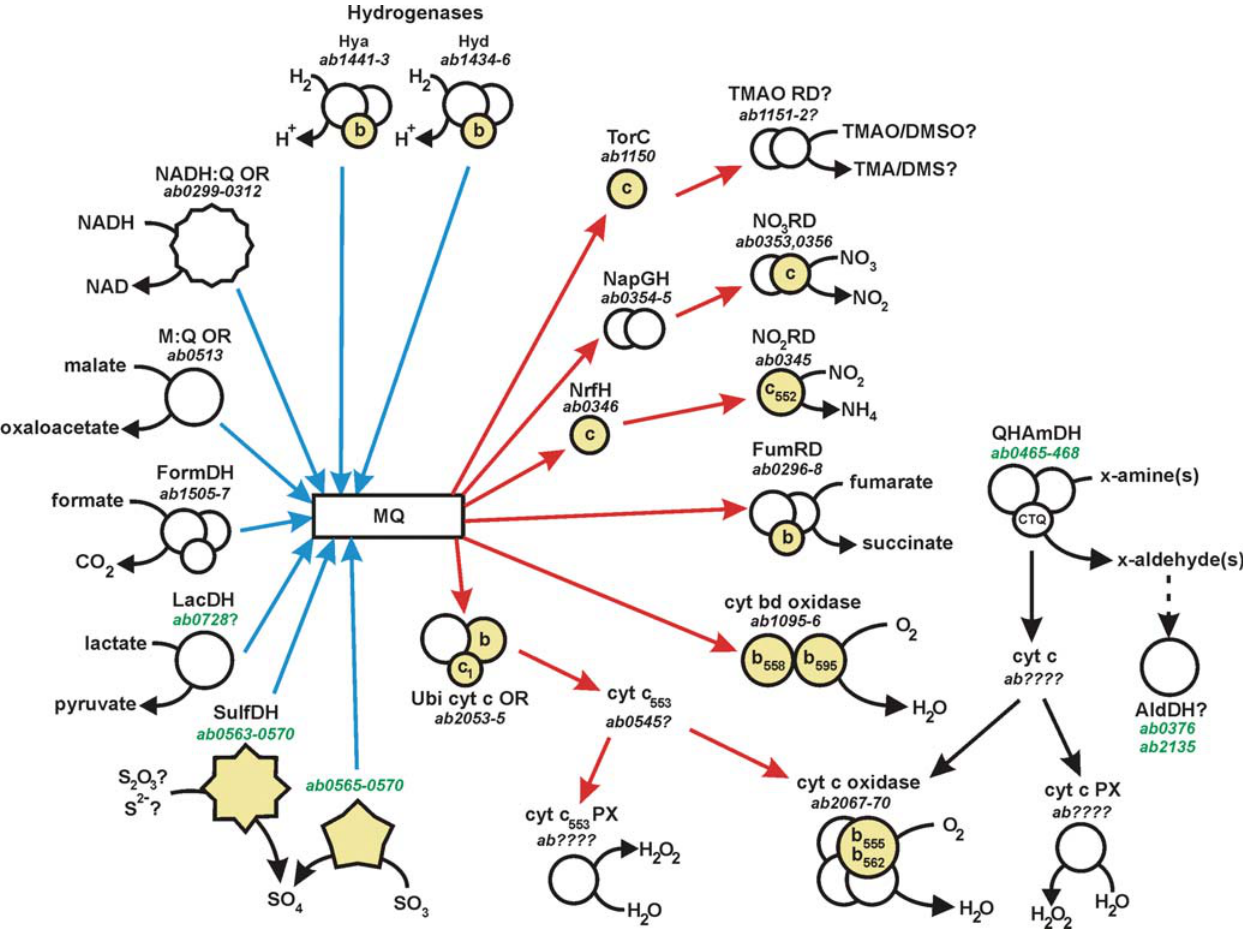
Figure 4. Respiratory pathways in A.butzleristrain RM4018. Transfer of electrons to the menaquinone (MQ) pool is represented by blue arrows; transfer of electrons from the menaquinone pool is represented by red arrows. b - and c -type cytochromes are shaded yellow. Genes unique within the Campylobacteraceae are labeled in green. NADH:Q OR: NADH:quinone oxidoreductase; M:Q OR: malate:quinone oxidoreductase; FormDH: formate dehydrogenase; LacDH: L-lactate dehydrogenase; SulfDH: sulfur dehydrogenase; Ubi cyt c OR: Ubiquinol cytochrome c oxidoreductase; TMAO RD: TMAO reductase; NO 3 RD: nitrate reductase; NO 2 RD: nitrite reductase; FumRD: fumarate reductase; QHAmDH: quinohemoprotein amine dehydrogenase; AldDH: aldehyde dehydrogenase; PX: peroxidase; CTQ: cysteine